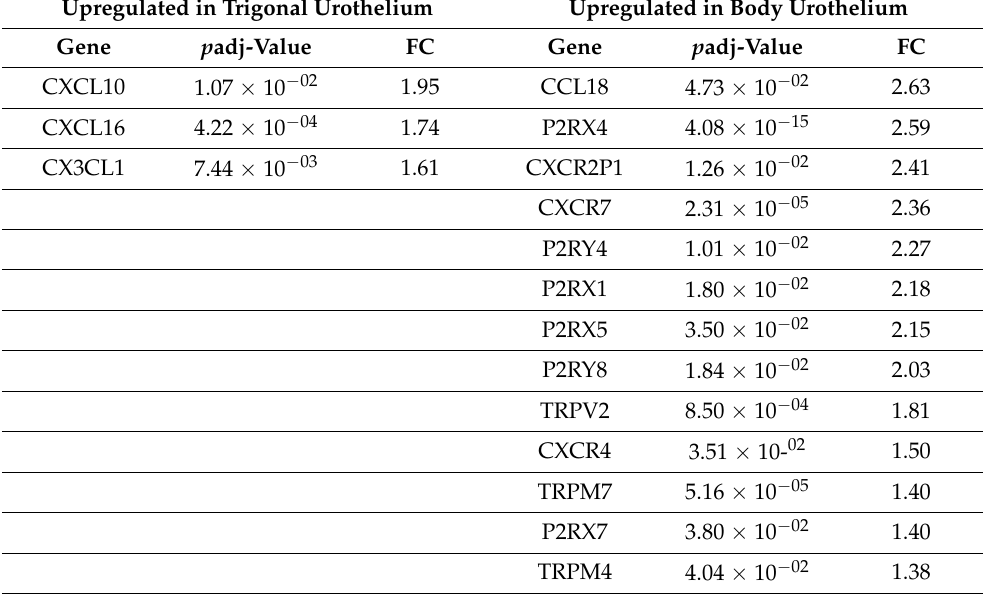
Table 2. Cont. Upregulated in Trigonal